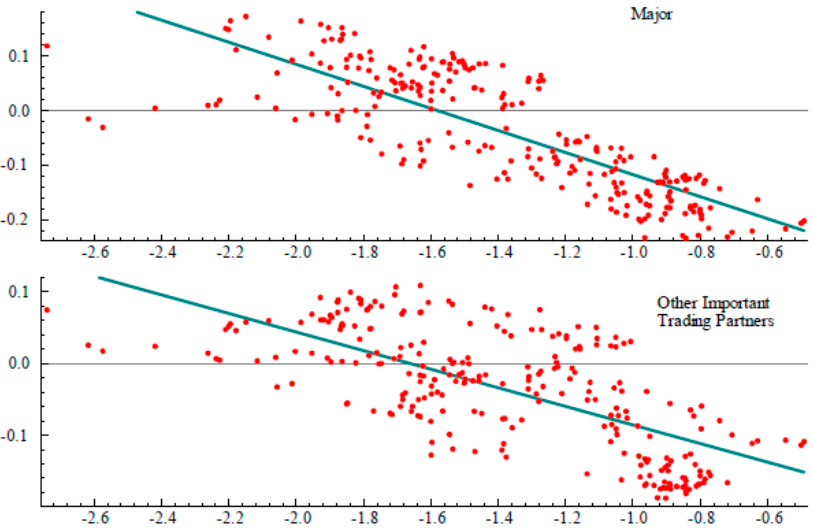
Figure 4. The horizontal axis represents the WTI price of oil deflated by the U.S. CPI; the vertical axis for the top panel represents the Federal Reserve’s measure for the real effective exchange rate for the major currencies. The vertical axis for the bottom panel represents the Federal Reserve’s measure for real effective exchange rate for the Other Important Trading Partners’ currencies. Variables are expressed in logarithms.